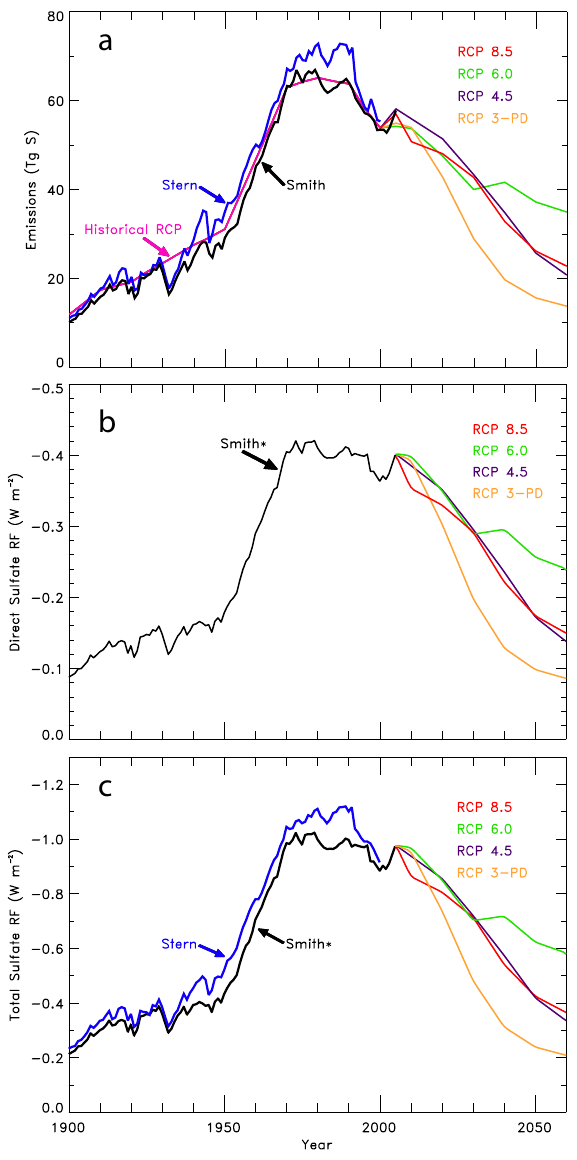
Fig. 2. (a) Global, annual anthropogenic emission of sulfur (S EMISS ) from RCP Potsdam compared to values published by Stern (2006b) and Smith et al. (2011). (b) Direct RF due to sul- fate aerosols (RF SULFATE − DIR ) from RCP Potsdam (post 2005) and the estimate of RF SULFATE − DIR (1900 to 2005) used in our model, labelled Smith ∗ , which is tied to S EMISS from Smith et al. (2011) and the IPCC (2007) estimate of − 0 . 4Wm − 2 for year 2005. (c) Total RF due to sulfate aerosols (RF SULFATE − TOT ) from David Stern, Australian National University, provided at the URL given in Appendix B, compared to the value of RF SULFATE − TOT used in our model, labelled Smith ∗ , found by multiplying Smith ∗ RF SULFATE − DIR by α COOL , for a value of α COOL = 2 . 4, chosen to yield match our estimate of RF SULFATE − TOT of − 0 . 96Wm − 2 for year 2005. Panels are all extended to 2060 for illustrative pur- poses, to support the statement in the paper that tropospheric aerosol forcing of climate will be diminishing over